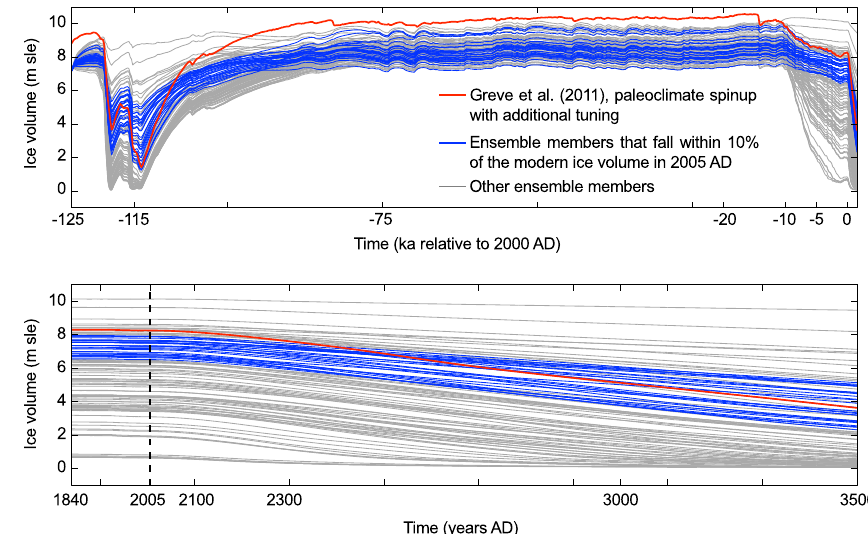
Fig. 3. Simulated ice volumes as a function of time for all 100 ensemble members, expressed in meters of sea level equivalent (m sle). All model runs begin at − 125ka before 2000 AD from the observed modern ice geometry, with an ice volume of ∼ 7.2m sea level equivalent (Bamber et al., 2001; see text). Blue curves: model runs that give ice volumes within 10% of estimated modern ice volume in 2005 AD (dashed line). Red line: time evolution of the “paleoclimate spinup with additional tuning” model run described by Greve et al. (2011). Labeled tick marks are those referred to in the text and figures; unlabeled tick marks are 25ka apart in the top panel and 200yr apart in the lower